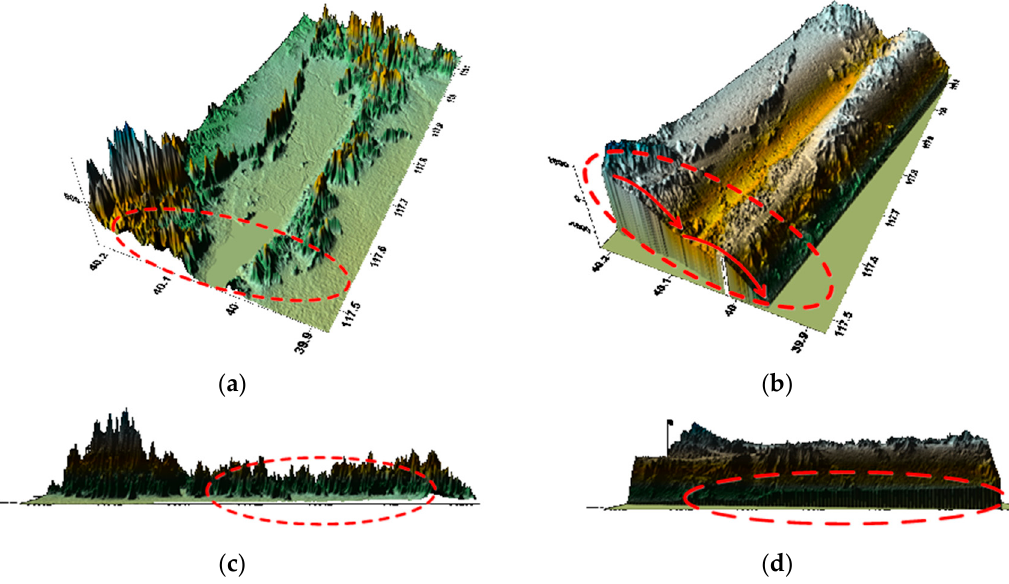
Figure 8. DEM product without any correction: ( a ) SRTM DEM along the latitude; ( b ) GF-3 generated DEM along the latitude; ( c ) SRTM DEM along the longitude; ( d ) GF-3 generated DEM along the